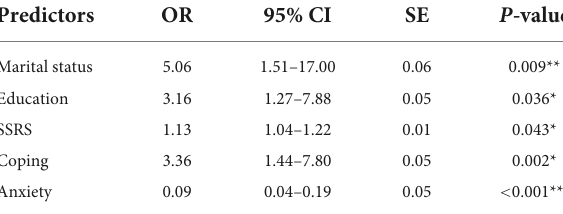
TABLE 2 Multivariable logistic regression model predicting